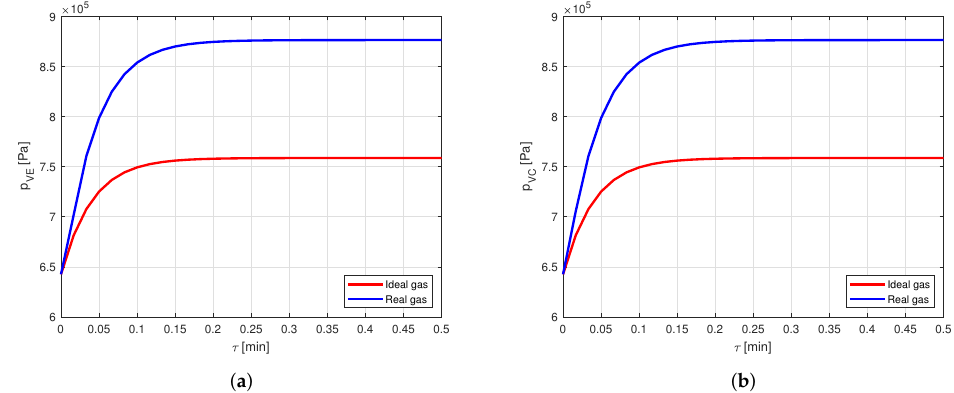
Figure 16. Comparison between the vapor pressures obtained by modeling the vapor as ideal or real gas, in a copper-HFC134a heat pipe. ( a ) Comparison of the vapor pressures at the evaporator. ( b ) Comparison of the vapor pressures at the